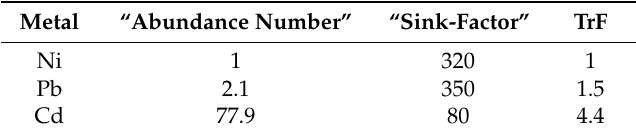
Table 2. Results of the calculation of the “abundance number”, “sink-factor”, and Toxic-response Factor for each element. Metal “Abundance Number”